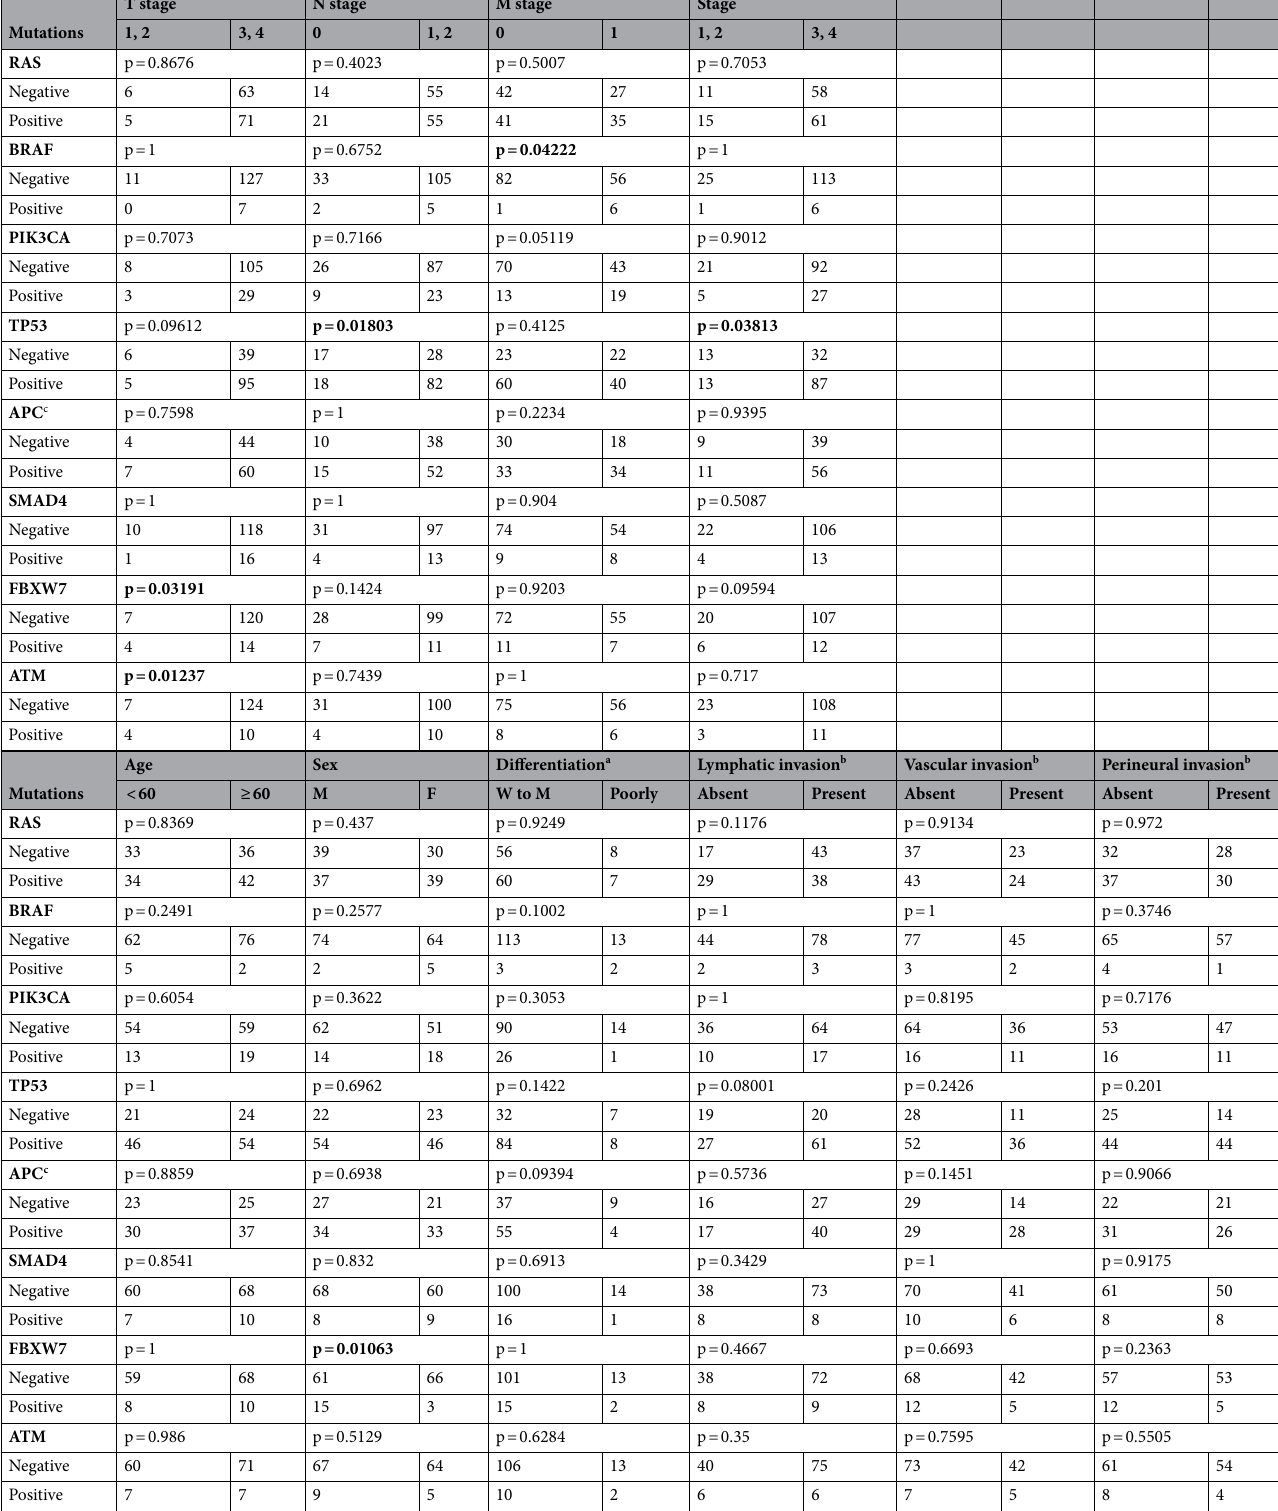
Table 2. Correlation of common gene mutations in CRC according to the clinicopathological data of our cohort. a A total of 14 cases have no available data. b A total of 18 cases have no available data. c A total of 30 cases have no available